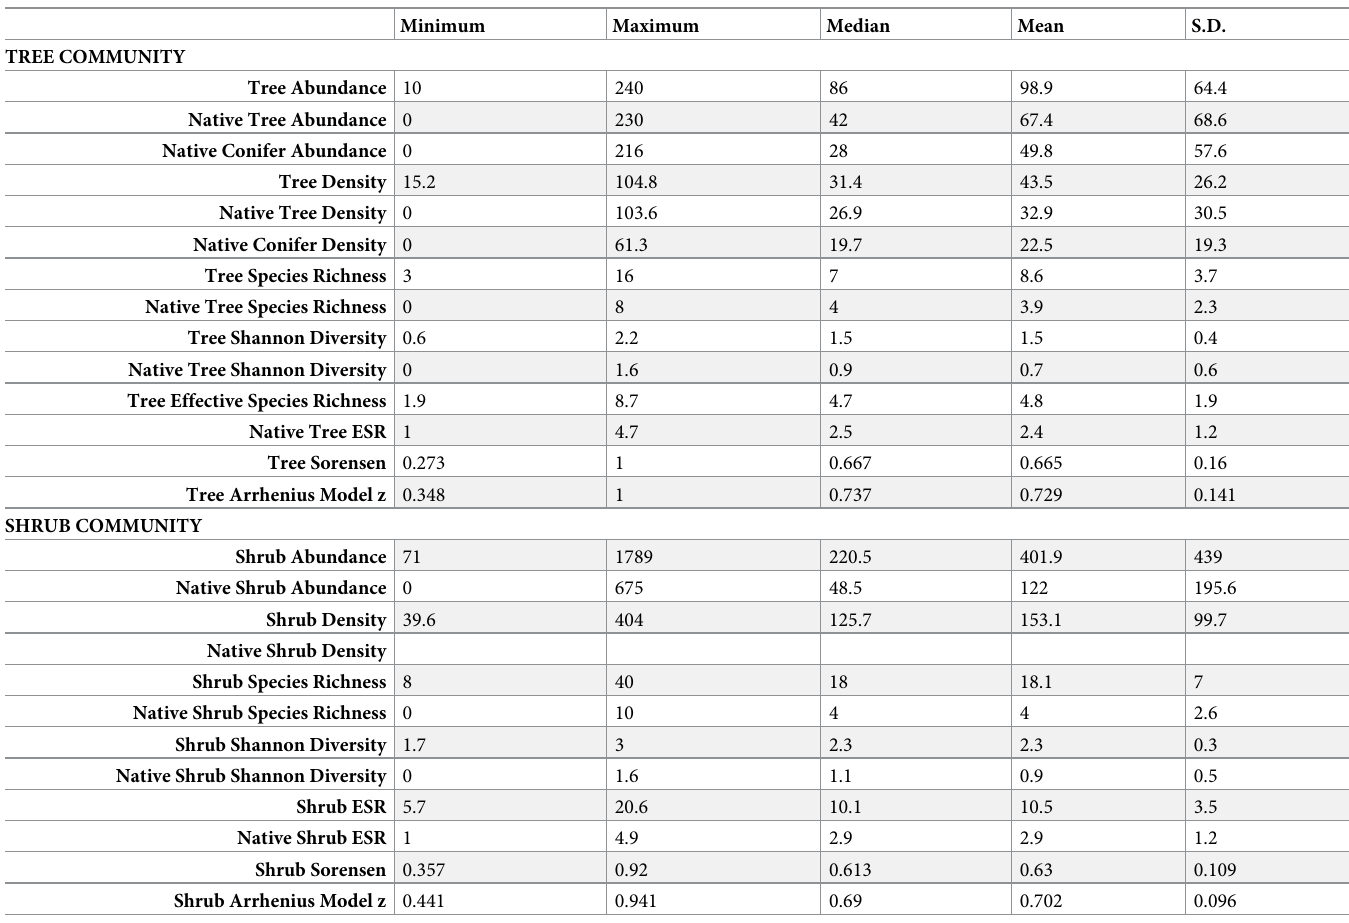
Table 3. Metrics for tree and shrub communities on sampled office